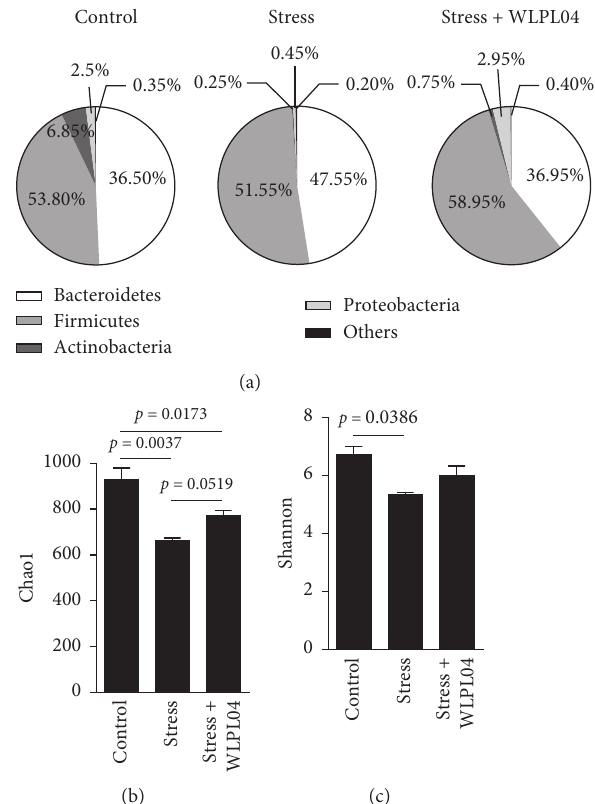
Figure 3: L . plantarum WLPL04 treatment rescues the negative change in the intestinal microbiota. (a) Aggregate microbiota composition at the phylum level in the fecal samples of experimental mice. Chronic stress significantly reduces the number of Firmicutes, and such negative effect is reversed by the L . plantarum WLPL04 treatment. Bacterial diversity and species richness as indicated by the (b) Chao1 and the (c) Shannon indices. The chronic stress tends to destroy the diversity and destroy the species richness, and such negative effects are rescued by the L . plantarum WLPL04 treatment. n � 12 mice per